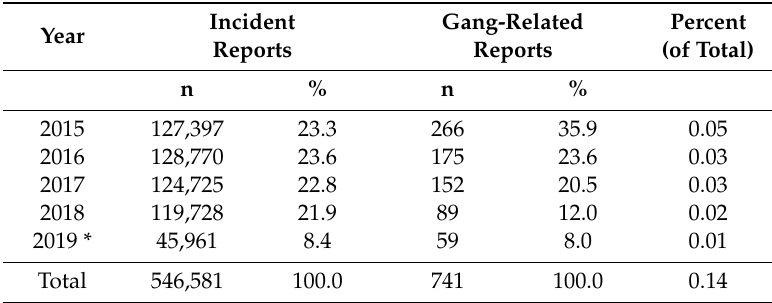
Table 1. Annual police incident